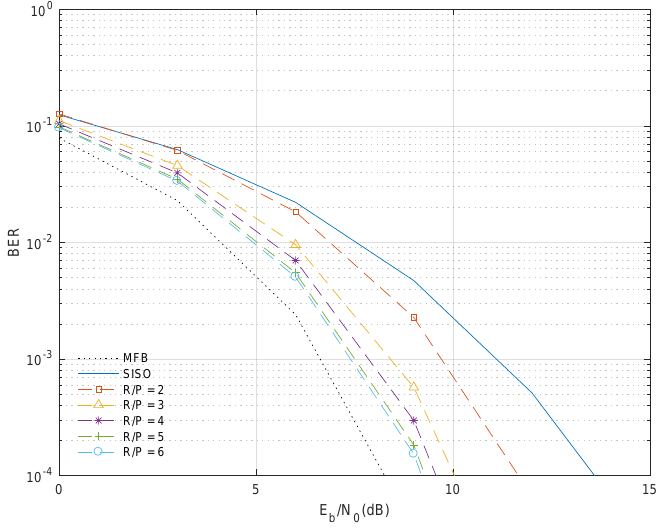
Figure 3. Theoretical BER performance for the first iteration when using IB-DFE for different R / P